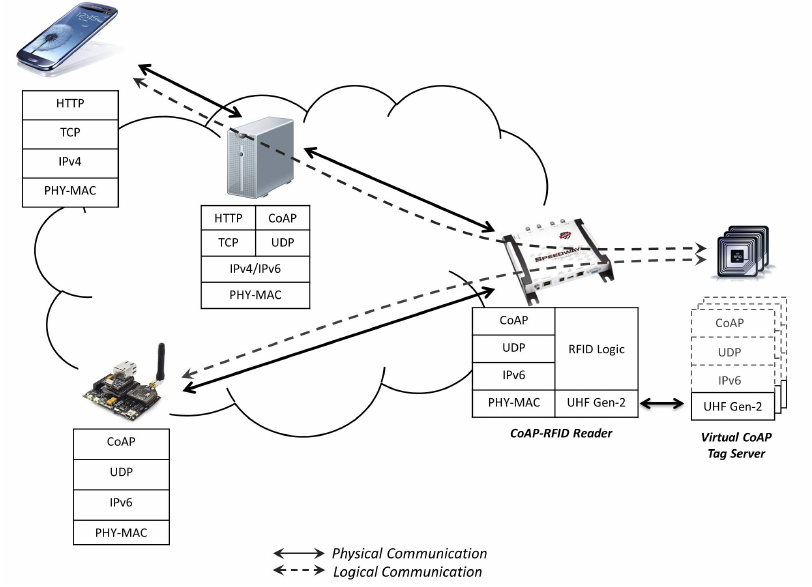
Figure 2. Protocol